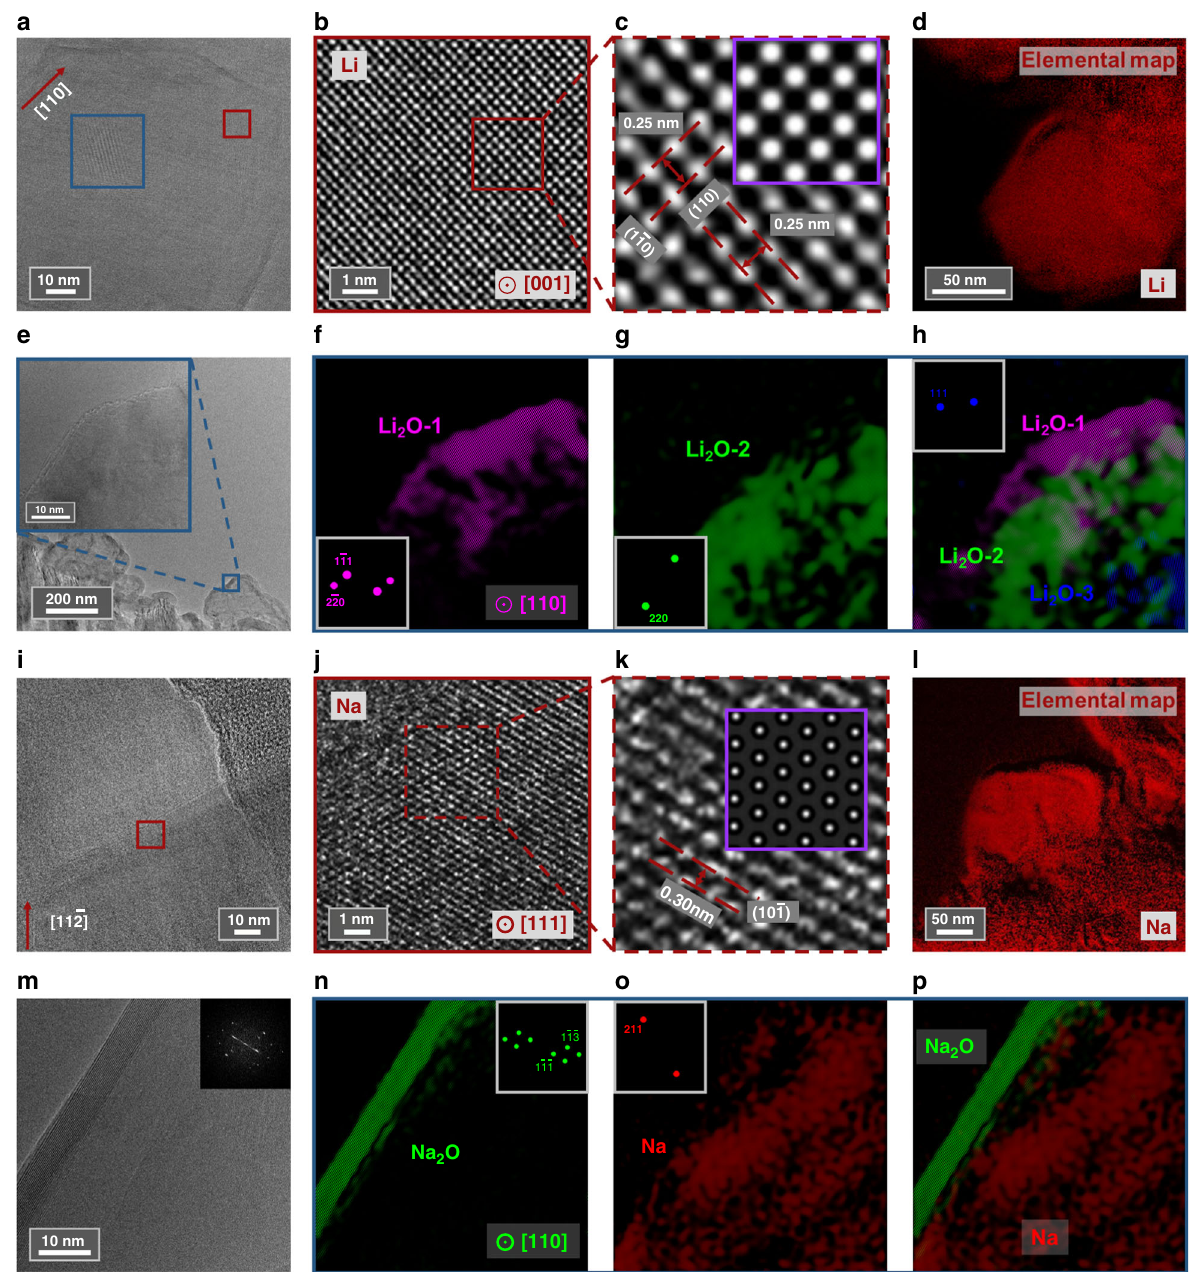
Fig. 4 AC-HRTEM of alkali metal particles. a A lithium particle grown along [110] direction. b AC-HRTEM of the particle, ( c ) partial enlarged view and simulated AC-HRTEM of lithium as inset. d EFTEM of a lithium particle. e Oxidized lithium particles and partial enlarged view as inset. f , g Lithium oxide with different orientations and their corresponding selected Fourier transformation spots as insets. h Superposition image of lithium oxide. i A sodium particle grown along [11 (cid:1) 2] direction. j AC-HRTEM of the particle, ( k ) partial enlarged view and simulated AC-HRTEM of sodium as inset. l EFTEM of a sodium particle. m Sodium oxide on the edge and its Fourier transformation spots inset. n , o Sodium oxide compounds, sodium, and their corresponding selected Fourier transformation spots inset, respectively. p Superposition image of different compounds. f – h, n – p These images are